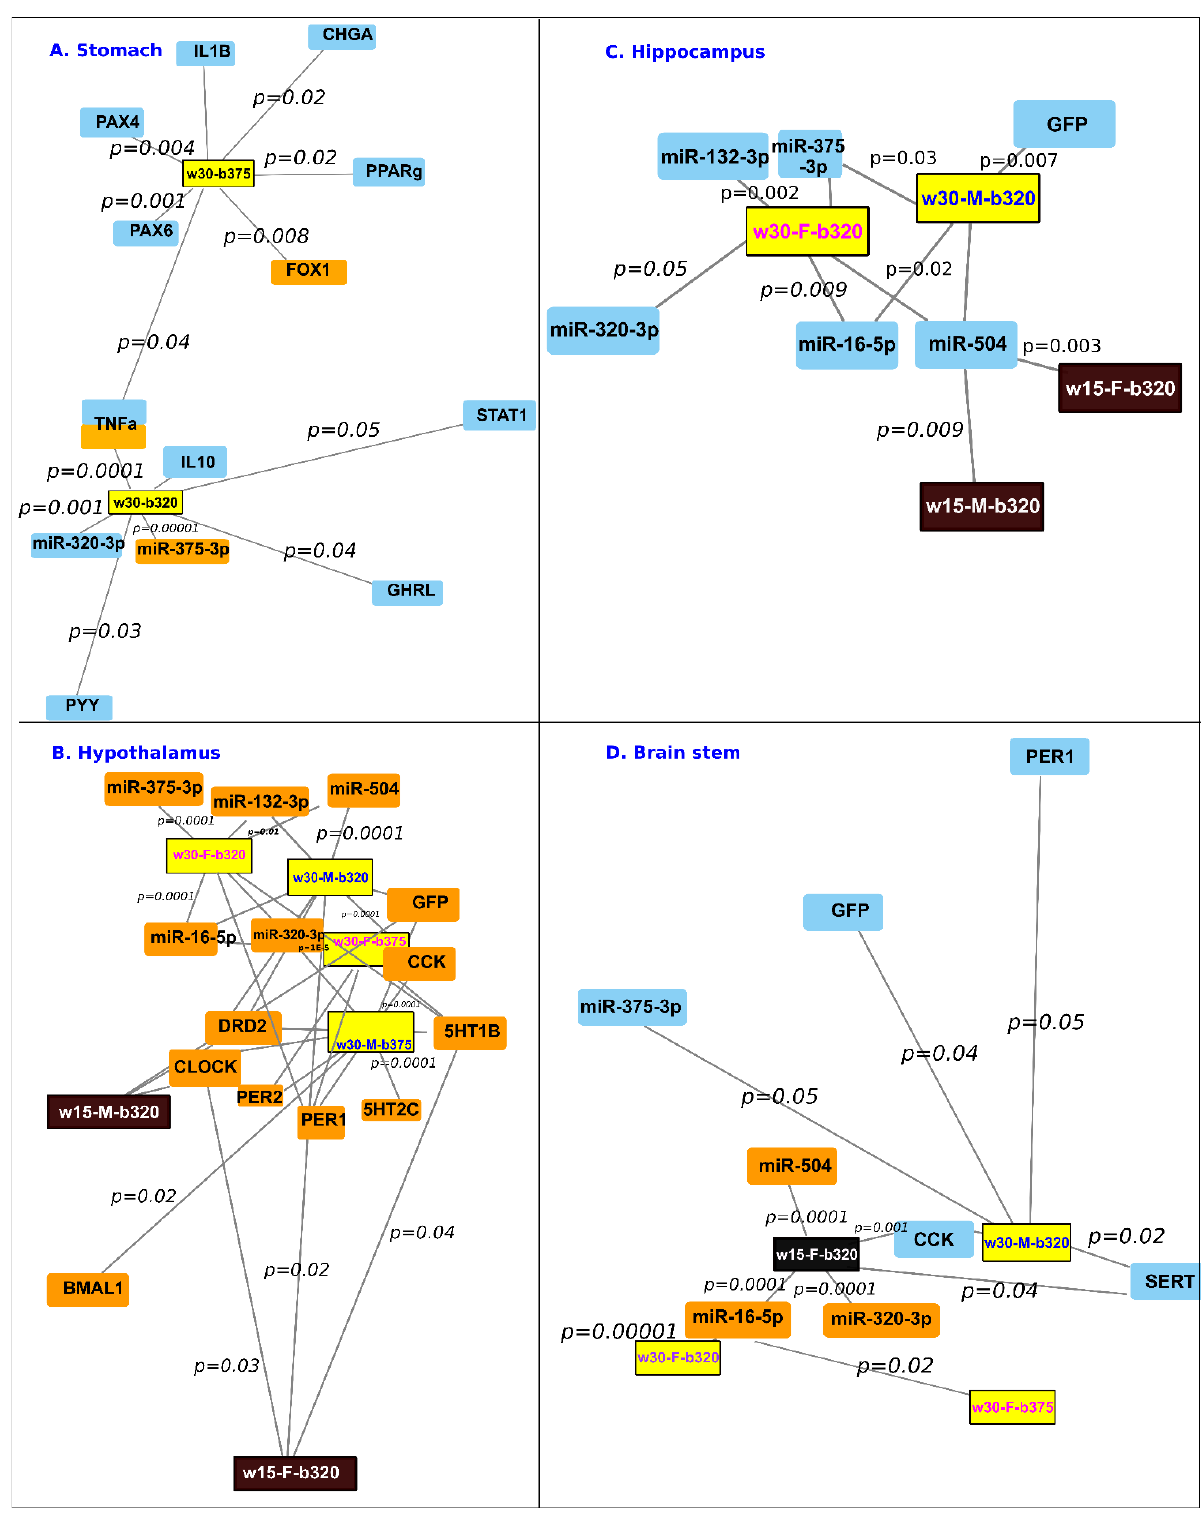
Figure 4. Network of genes significantly deregulated in the stomach wall ( A ), hypothalamus ( B ), hippocampus ( C ), and brain stem ( D ) for miR-320-3p/DOSP treatment according to early (w15) or regular (w30) weaning and of miR-375-3p/DOSP with regular weaning. Note the upregulation of miR-320-3p, miR-504, and miR-16-5p in the female brain stem. Edge length is inversely proportional to the p significant threshold. The p values are indicated in italic. Orange upregulated, blue down-regulated.